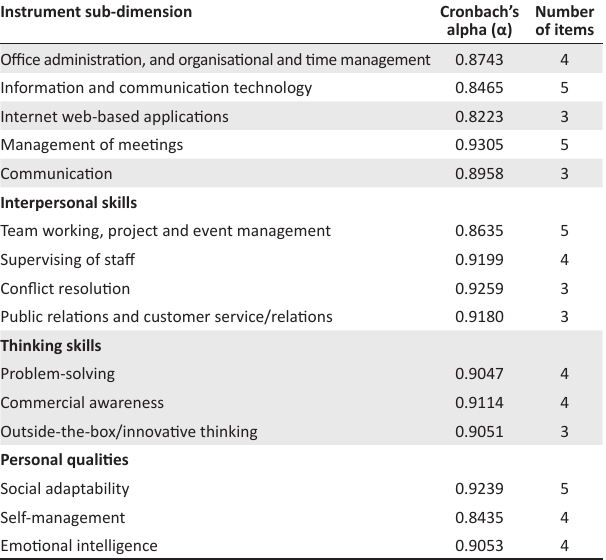
TABLE 3: Cronbach’s alpha ( a ) for the sub-scales of the measurement. Instrument